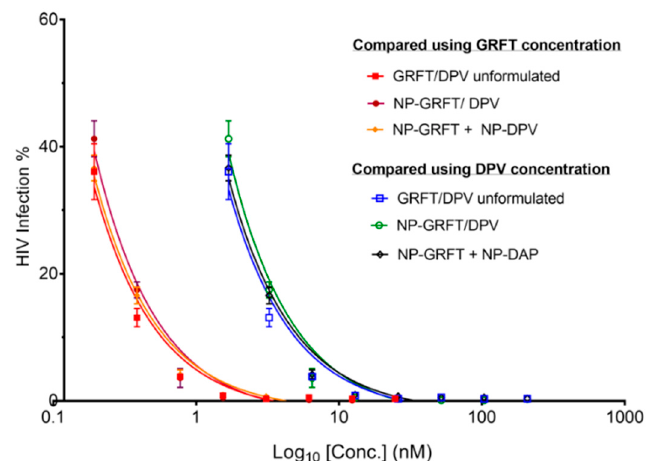
Figure 8. Potent and comparable anti-HIV effect of GRFT and DPV combinations. The dose-response curve shows potent antiviral activity of the combination of free drugs (GRFT/DPV unformulated), combination of single ARV nanoparticles (NP-GRFT + NP-DPV), and nanoparticles encapsulating both GRFT and DPV (NP-GRFT/DPV). Comparable inhibition of HIV infection was achieved with combination nanoparticles although the ARV ratio is not maintained at equipotency values (1:1 IC 50 or 1:8 molar ratio for GRFT:DPV).